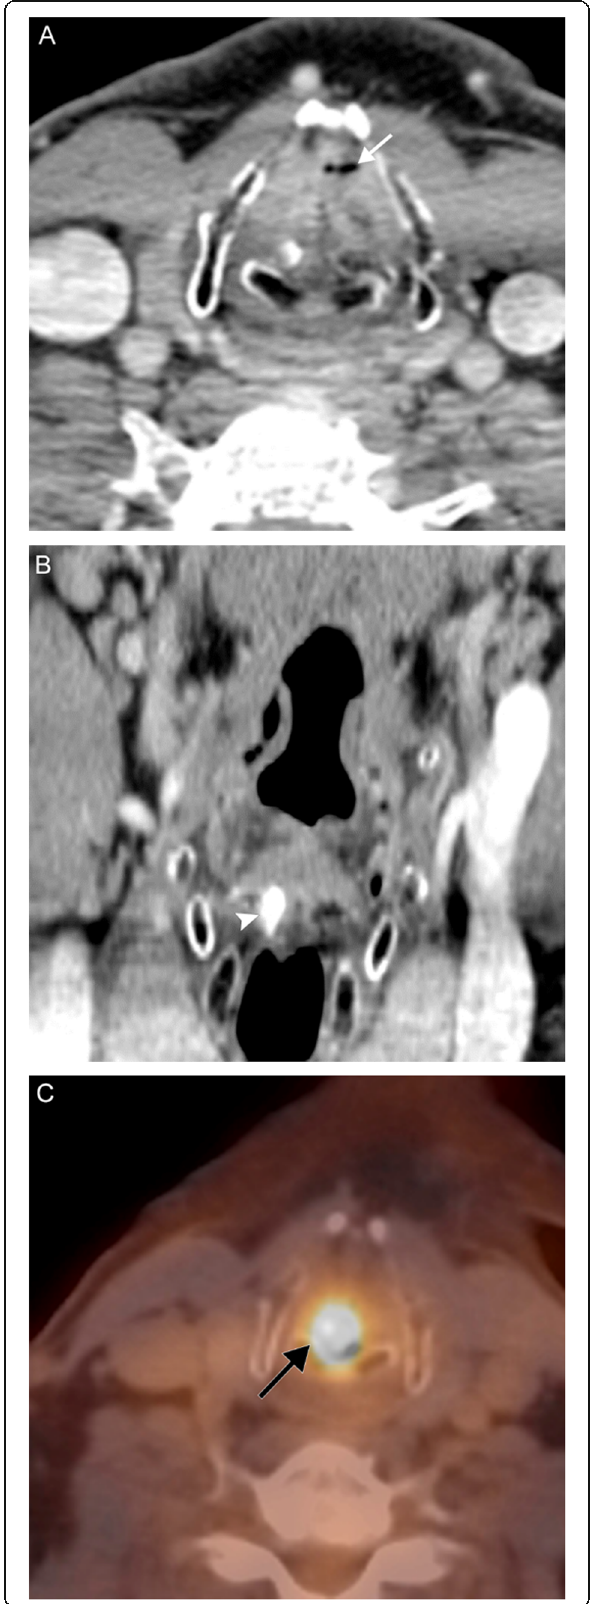
Fig. 6 Laryngeal carcinoma. A 59-year-old man with 45-pack-year smoking history presenting with 6 weeks of hoarseness. Axial ( a ) and coronal ( b ) contrast-enhanced CT images reveal near-complete obliteration of the laryngeal airway by a polypoid soft tissue mass, which extends inferiorly into the subglottic airway. Note the trace residual airway remnant anteriorly (white arrow). There is asymmetric high attenuation of the right arytenoid cartilage (white arrowhead), consistent with sclerosis and involvement of the lesion. Axial fusion PET/CT image ( c ) reveals a hypermetabolic mass centered at the larynx (black arrow). Biopsy revealed squamous cell